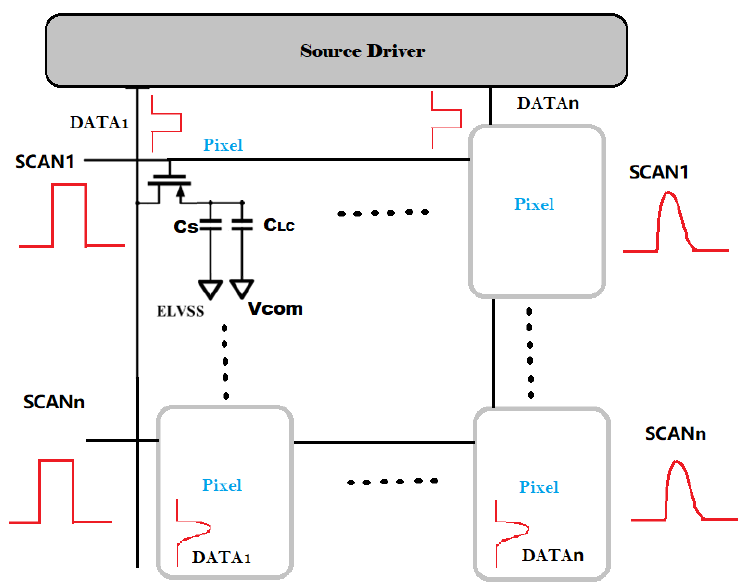
Figure 2. Pixel circuit and schematic diagram of an LCD panel.